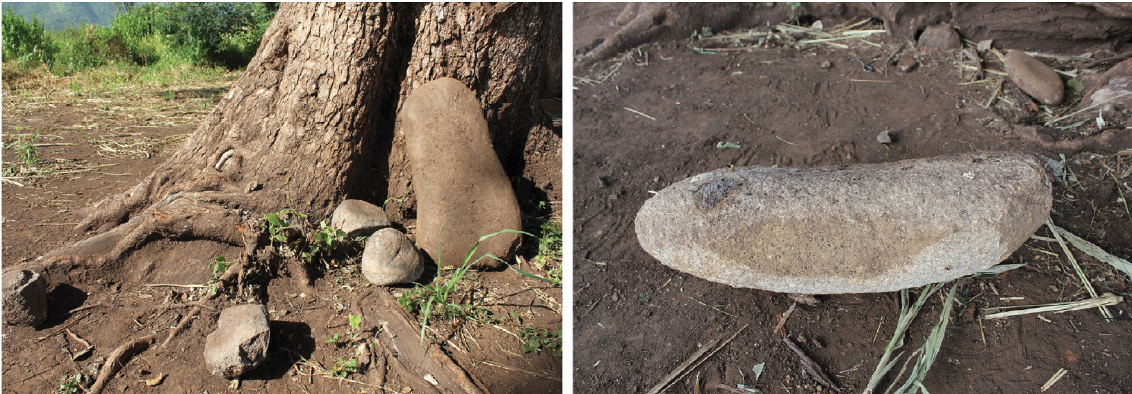
Figure 2. A quern waiting to be manufactured and a quern in manufacture. Manufacturing is done by pecking the stone until an appropriate shape is